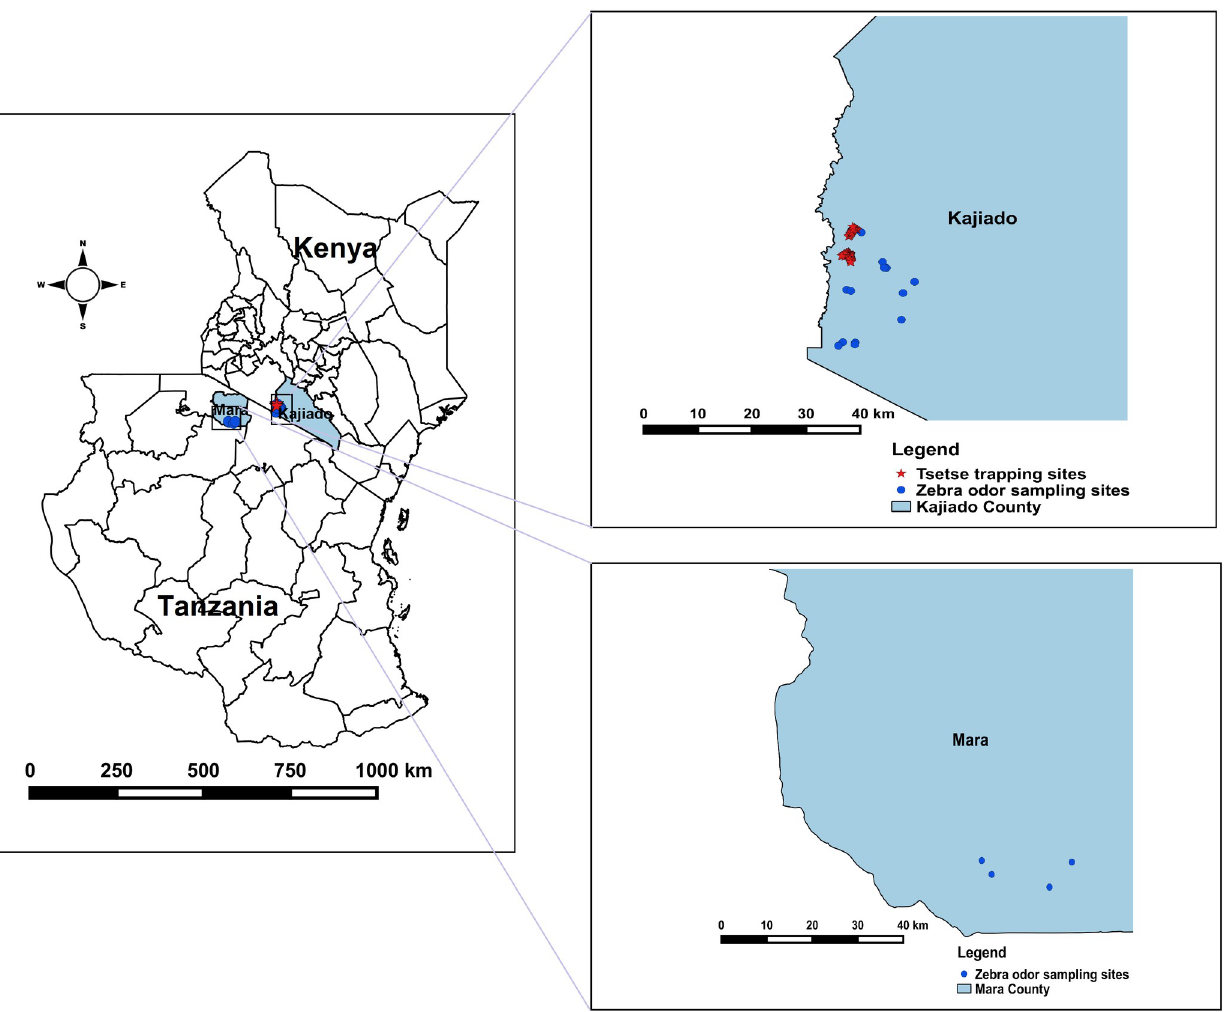
Fig 1. Map of Kenya and Tanzania showing the zebra skin odor sampling and tsetse trapping sites. The maps were designed using QGIS 2.8.3 (http:// www.qgis.org/en/site/forusers/download.html), which is an open source software. The coordinates of zebra odor sampling sites and tsetse trapping sites were obtained in the field using a GPS gadget (garmin etrex 20, https://buy.garmin.com/en-US/US/p/518046). The shape files (Kenya, Tanzania) were downloaded from DIVA GIS (http://www.diva-gis.org/gdata), also an open source.